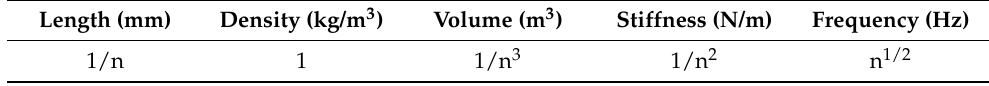
Table 1. The parameters used for scaling after Wood et al.